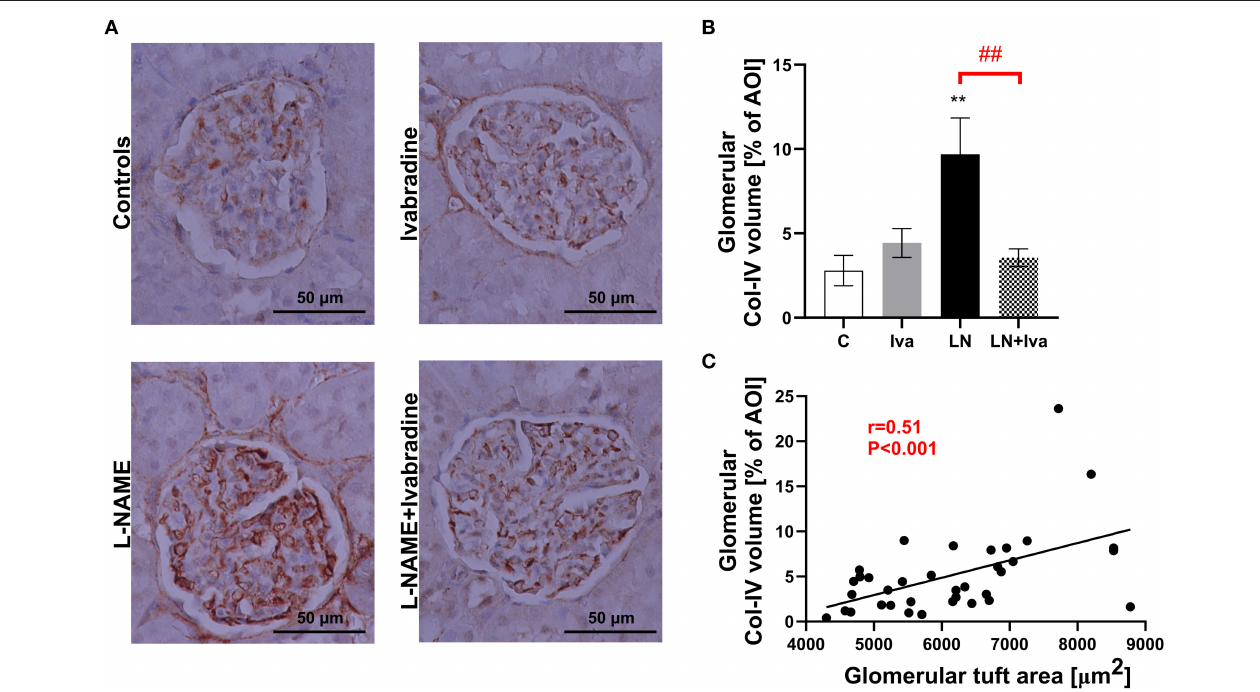
FIGURE 3 | Effect of ivabradine on type IV collagen volume in glomeruli (A,B) and the relationship between glomerular tuft area and glomerular type IV collagen volume (C) in L-NAME-induced hypertension after 4 weeks of treatment. For (A) : anti-collagen IV-immunostained sections at 200x magnification using transmitted light microscopy. For (B) : C, controls; Iva, ivabradine; LN, L-NAME; n = 9 animals per group. One-way two-tailed ANOVA followed by Holm–Sidak post-hoc test ; ** P < 0.01 vs. C; ## P < 0.01 vs. LN. For (C) : AOI, area of interest; Col-IV, type IV collagen. Spearman correlation; n = 9 animals per group.